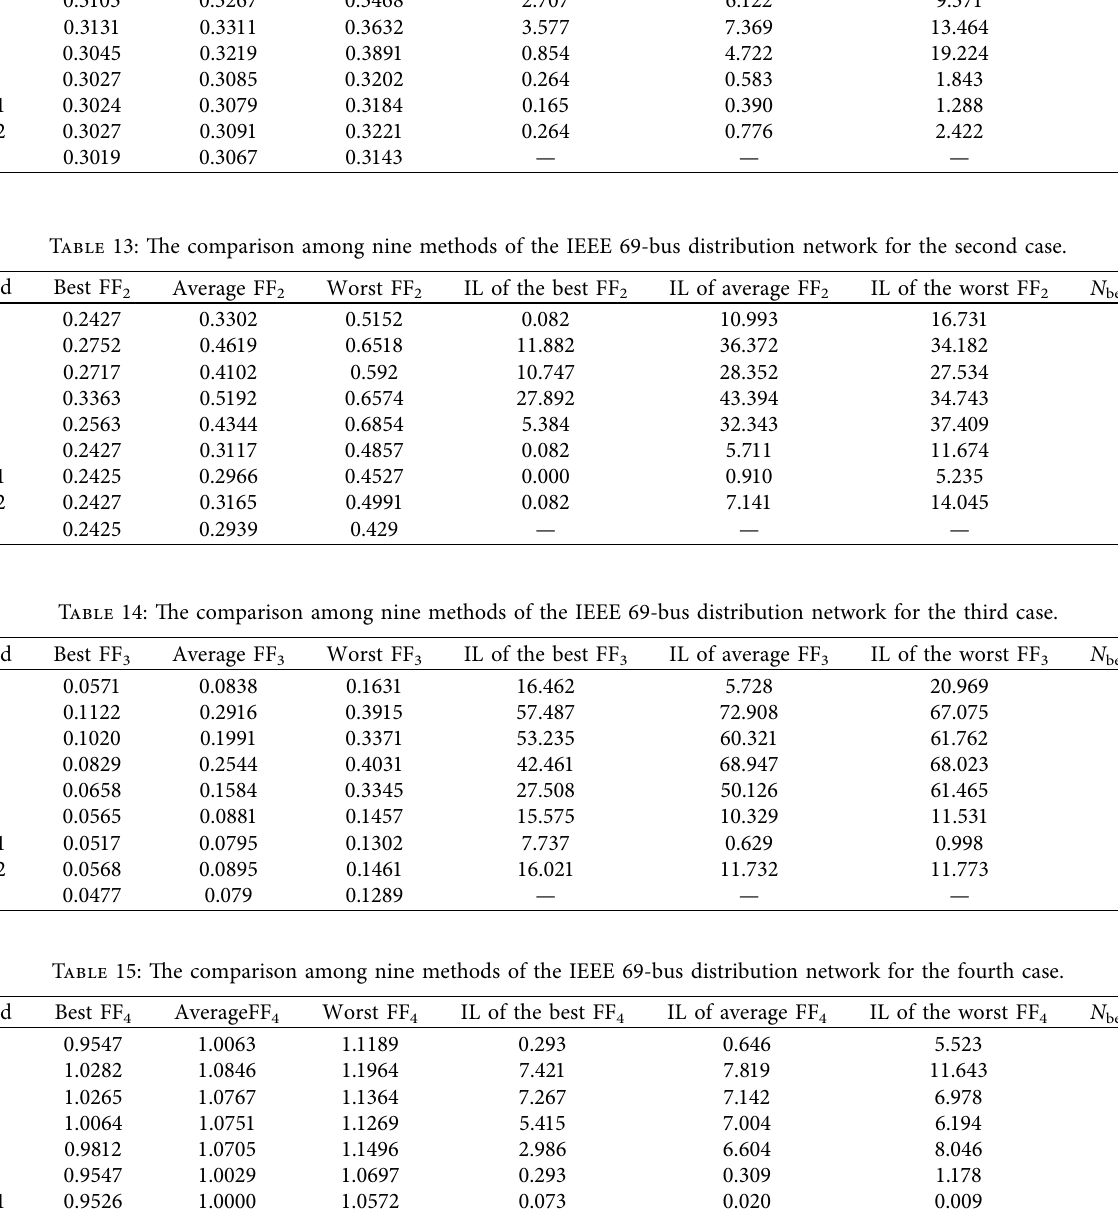
Table 12: The comparison among nine methods of the IEEE 69-bus distribution network for the first case. Method